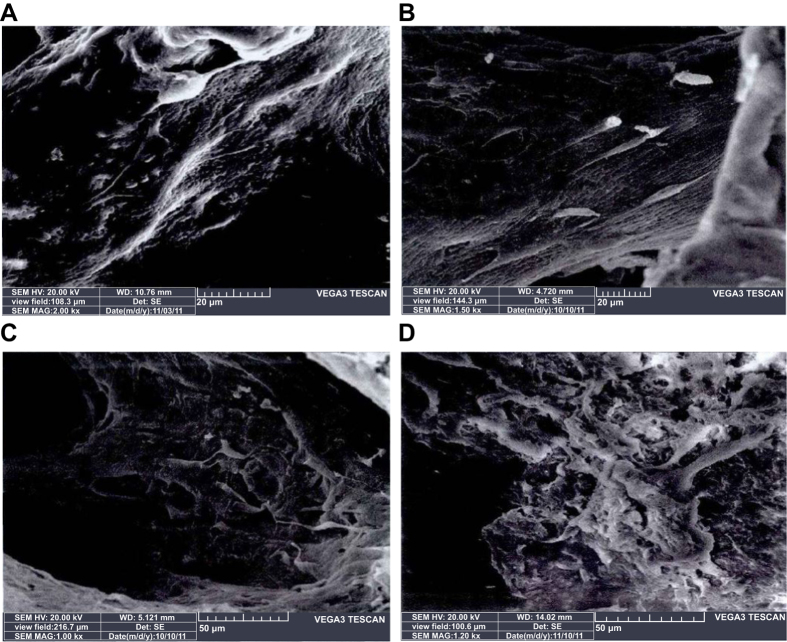
In vitro co-culture of EPCs-RFP and DBM grafts among five groups.Note: (A) in vitro co-culture of EPCs-RFP and DBM grafts at the 3rd day (×2000); (B) in vitro co-culture of EPCs-RFP and DBM grafts at the 7th day (×1500); (C) in vitro co-culture of EPCs-RFP and DBM grafts at the 10th day (×1000); (D) in vitro co-culture of EPCs-RFP and DBM grafts at the 14th day (×1200).